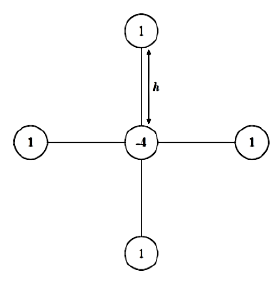
Fig. 2. Computational molecules of five-point